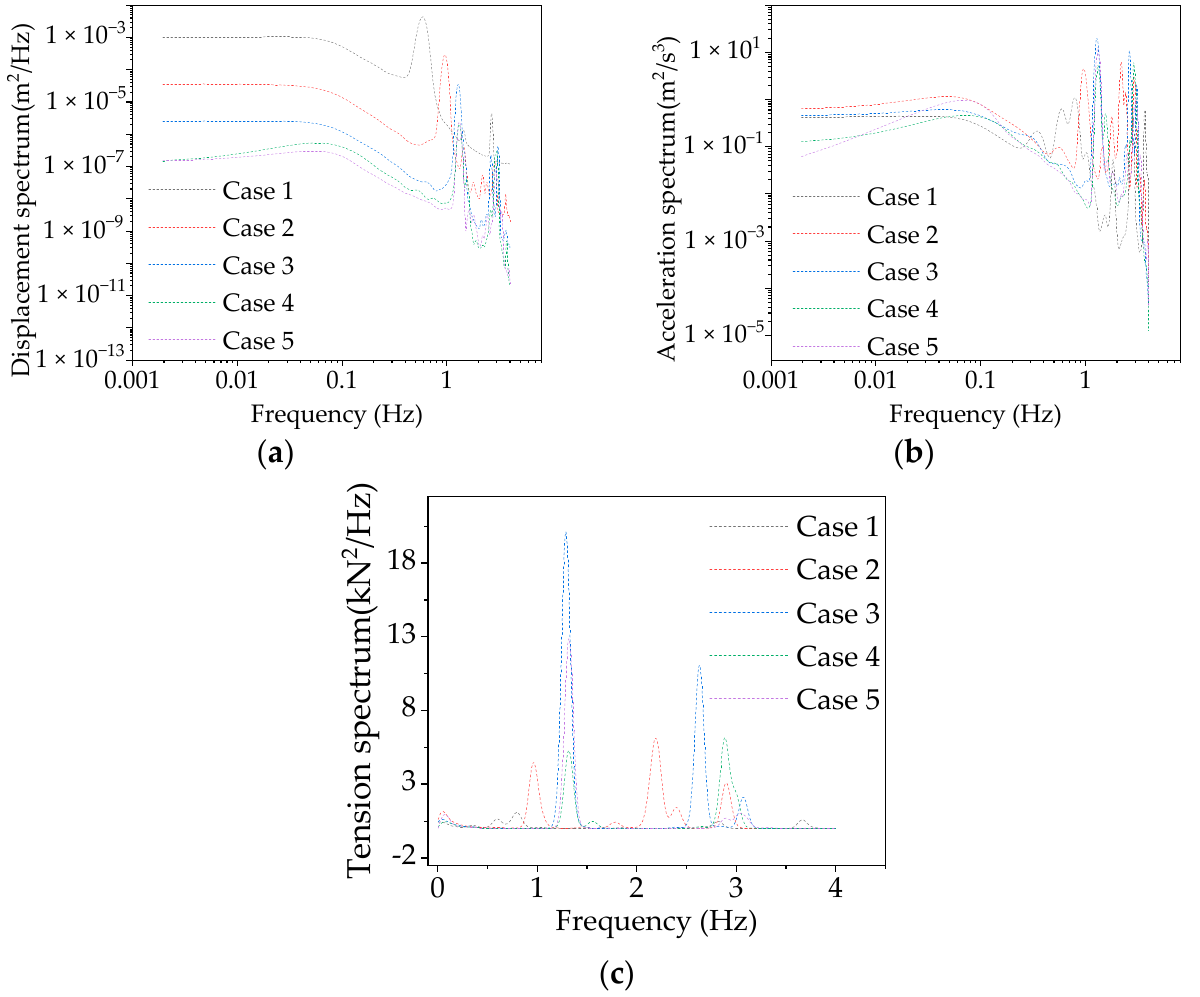
Figure 13. Spectrum analysis of bridge and stayed cable. ( a ) Bridge displacement spectrum, ( b ) Bridge acceleration spectrum, ( c ) Stayed cable tension spectrum.